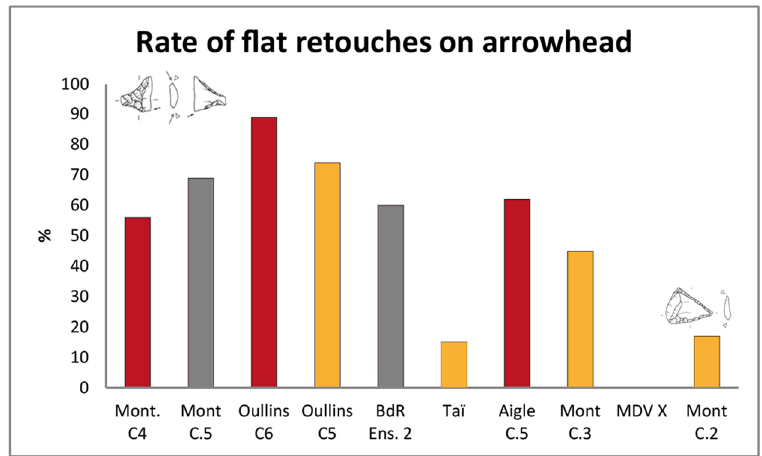
Figure 6: Evolution of the rate of fl at retouch on the armatures in corpuses with more than 10 elements. Assemblages attributed to the Cardial in red, Epicardial in orange, assemblages not associated with a pottery facies in grey. Mont: Montclus, BdR: Baume de Ronze, MDV X: Mas de Vignoles X. Data from Bevilacqua, 1995, Defranould, 2019, and Perrin,